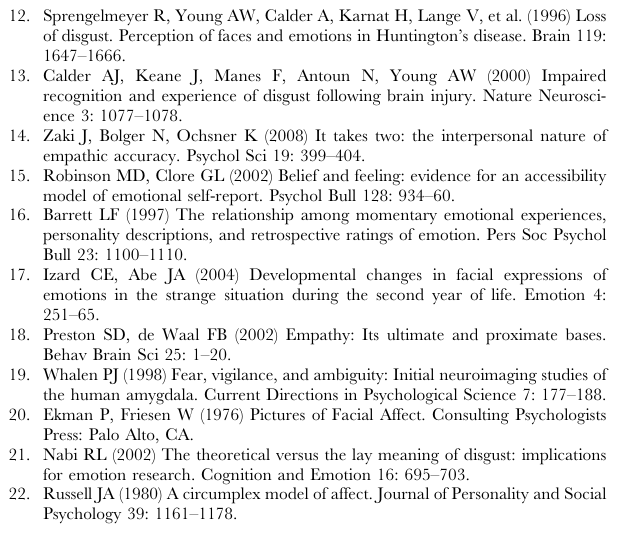
Figure S2 Distributions of Facial Affect Recognition. Histo- grams depicting the distributions of the raw slider placements for